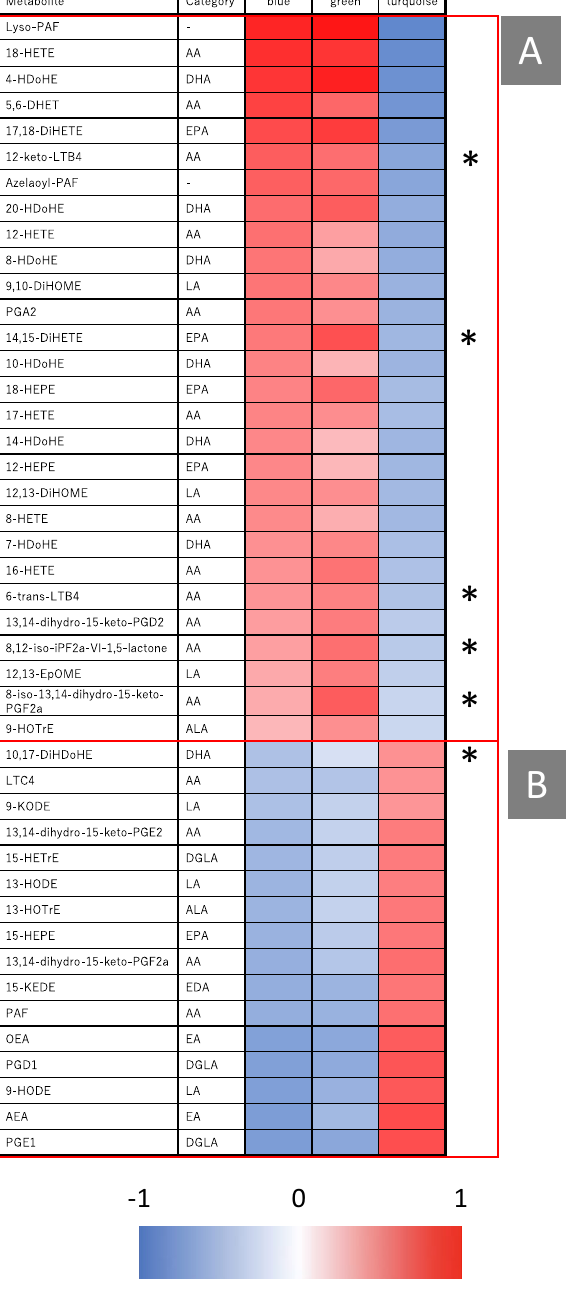
Figure 4. Correlation between gene expression networks and the lipid mediator profile. ( a ) Correlation between modules detected by WGCNA (blue, green, and turquoise) and lipid mediator profile. Correlations between the gene expression profile and the lipid mediator profile, which was used as trait, were analyzed by WGCNA. Asterisks indicate lipid mediators that were significantly altered by MT relative to IVI. ( b ) Pathway mapping of lipid mediators in lung. The WGCNA correlation score of the blue (left column), green (middle column), and turquoise (right column) modules of detected lipid mediators were mapped on the metabolic pathway. Lipid mediators that were detected but not included in the WGCNA modules are indicated by small grey-filled squares. *P < 0.05 for IVI + MT versus IVI by Welch’s t-test with Bonferroni’s multiple